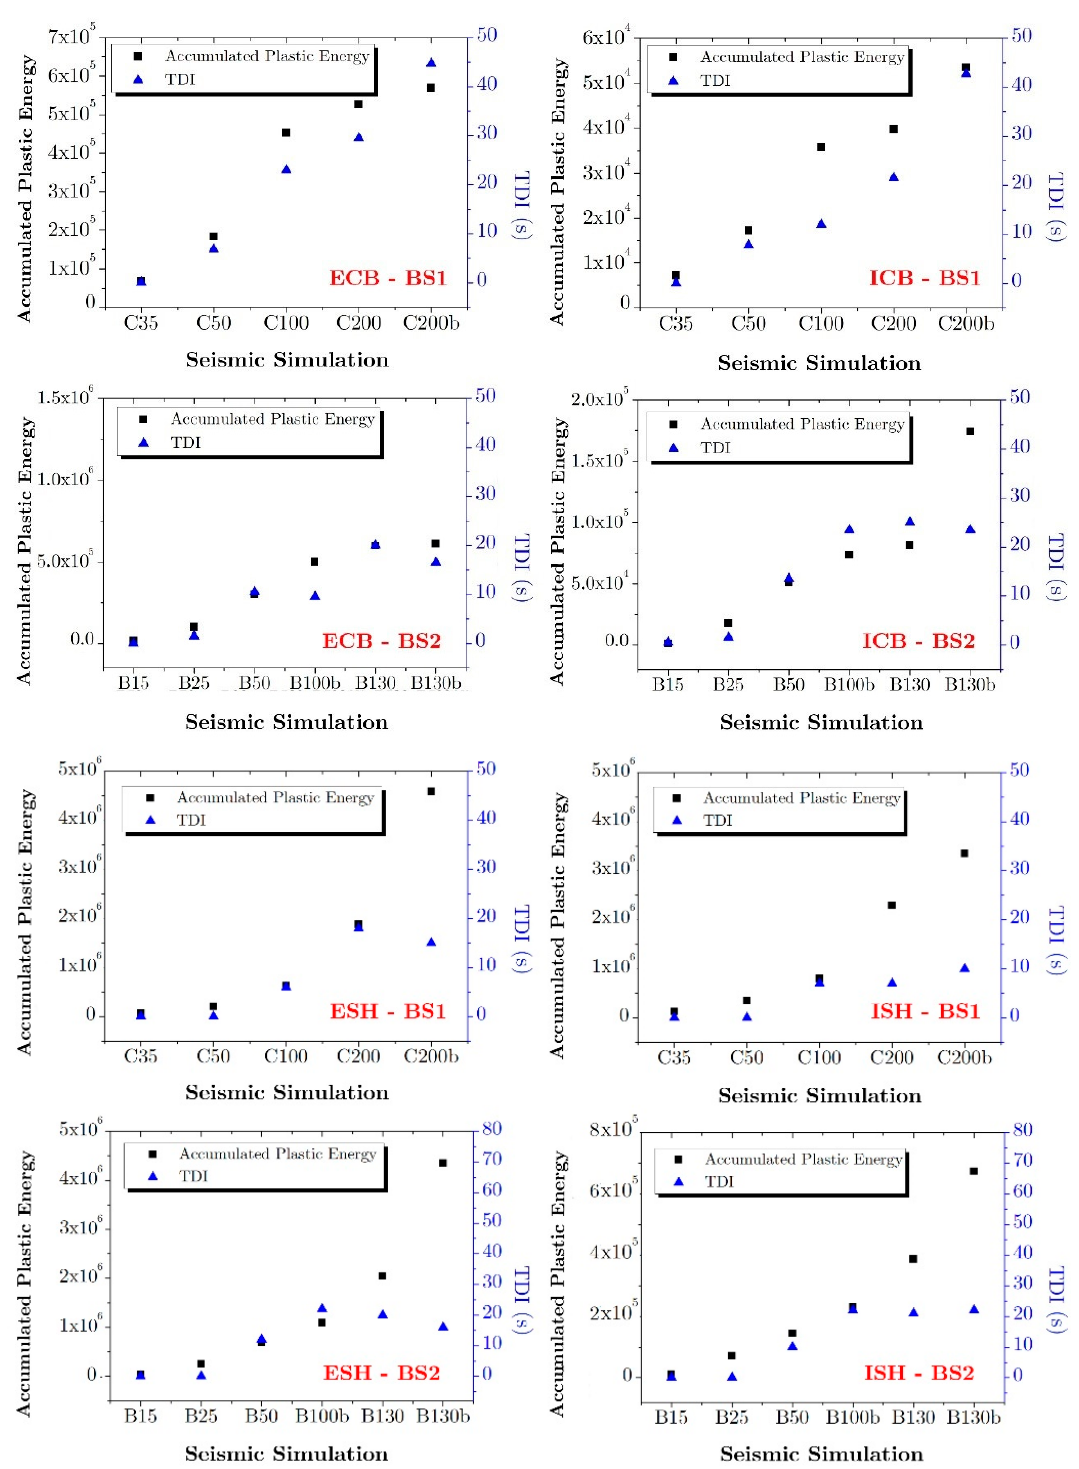
Figure 14. Correlation between the accumulated plastic energy W C , p and the temporal damage index